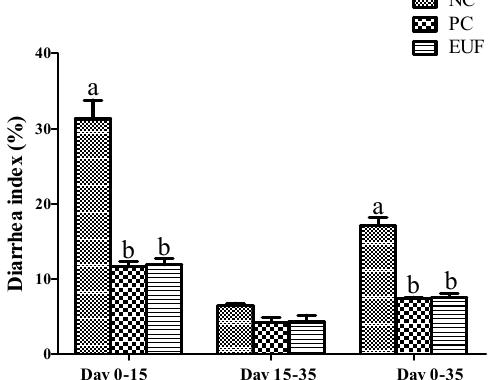
Figure 2. Diarrhea index: NC = negative control, low-protein basal diet no antibiotics included; PC = positive control, low-protein basal diet + antibiotics (75 mg/kg quinocetone, 20 mg/kg virginomycin, and 50 mg/kg aureomycin); EUF = Eucommia ulmoides flavones, low-protein basal diet + 0.01% EUF. Values are the mean ± SEM, n = 8 per treatment group. a,b Values with different letters are significantly different ( p < 0.05).